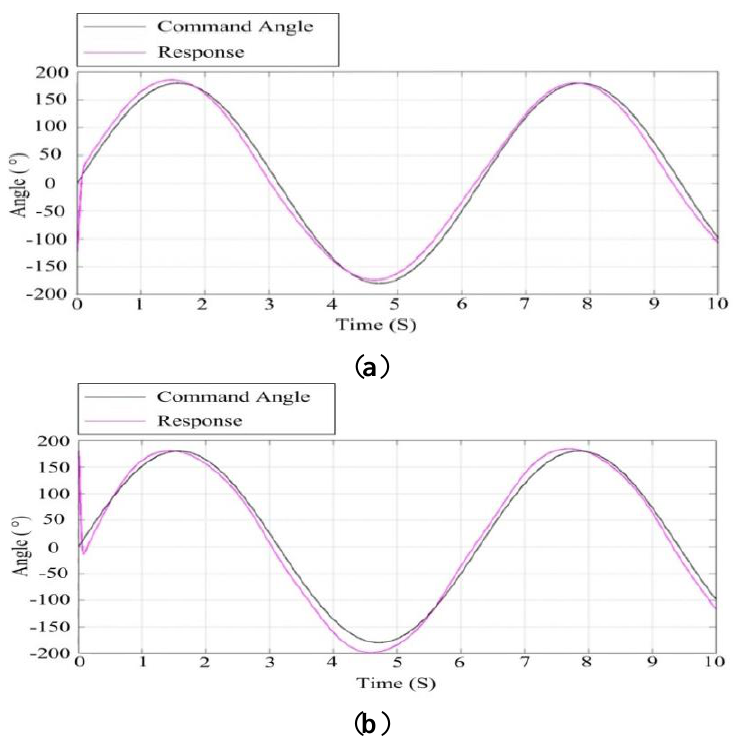
Figure 17. Response curves of ISP at the wind speed of 10 m/s: ( a ) the azimuth gimbal; ( b ) the pitch gimbal.